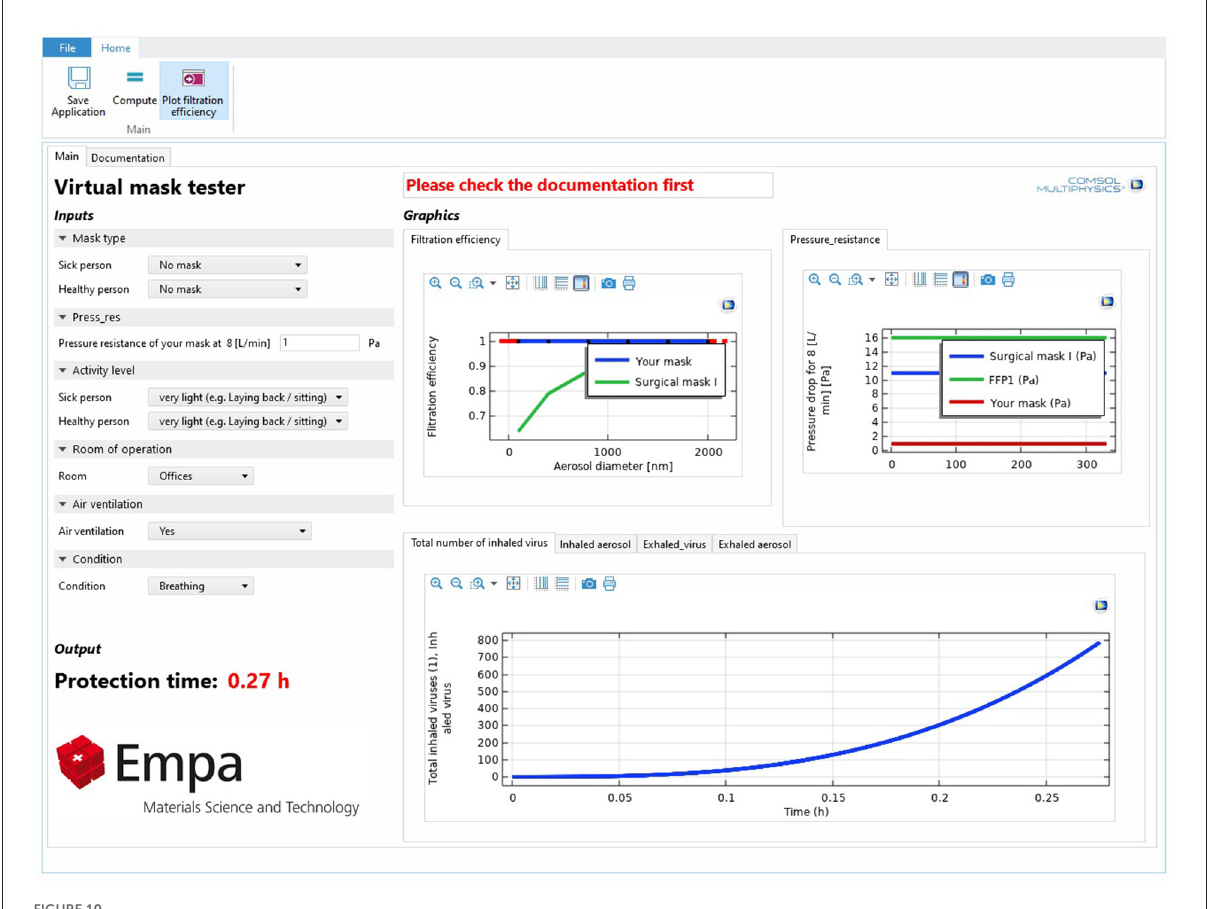
FIGURE10 Virtual mask tester application